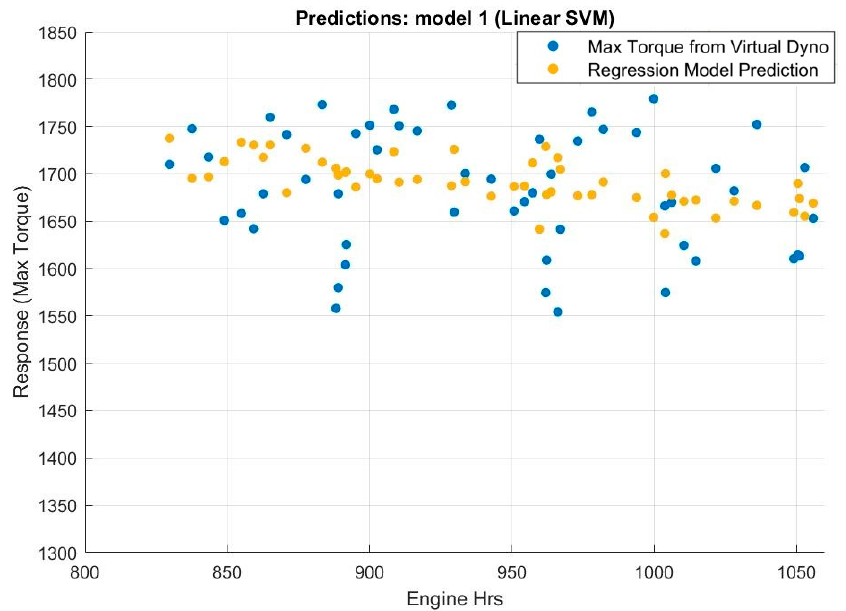
Figure 13. Max torque from virtual dyno (blue) and predicted values (yellow) using linear support vector machines (SVM).